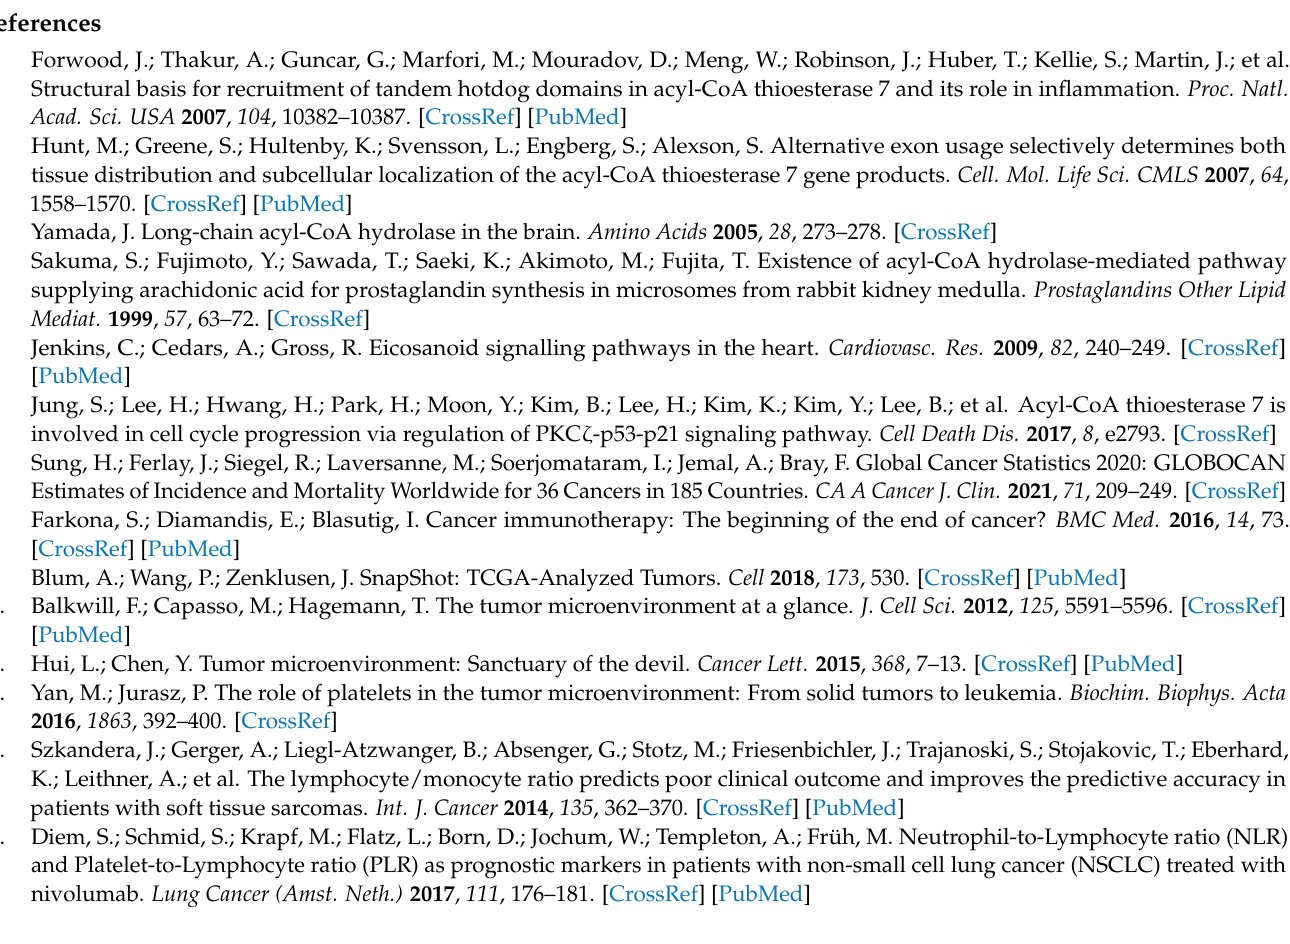
Table S1: Characteristic information of 33 cancers; Table S2: Correlation between ACOT7 expression and immune cell infiltration in eight